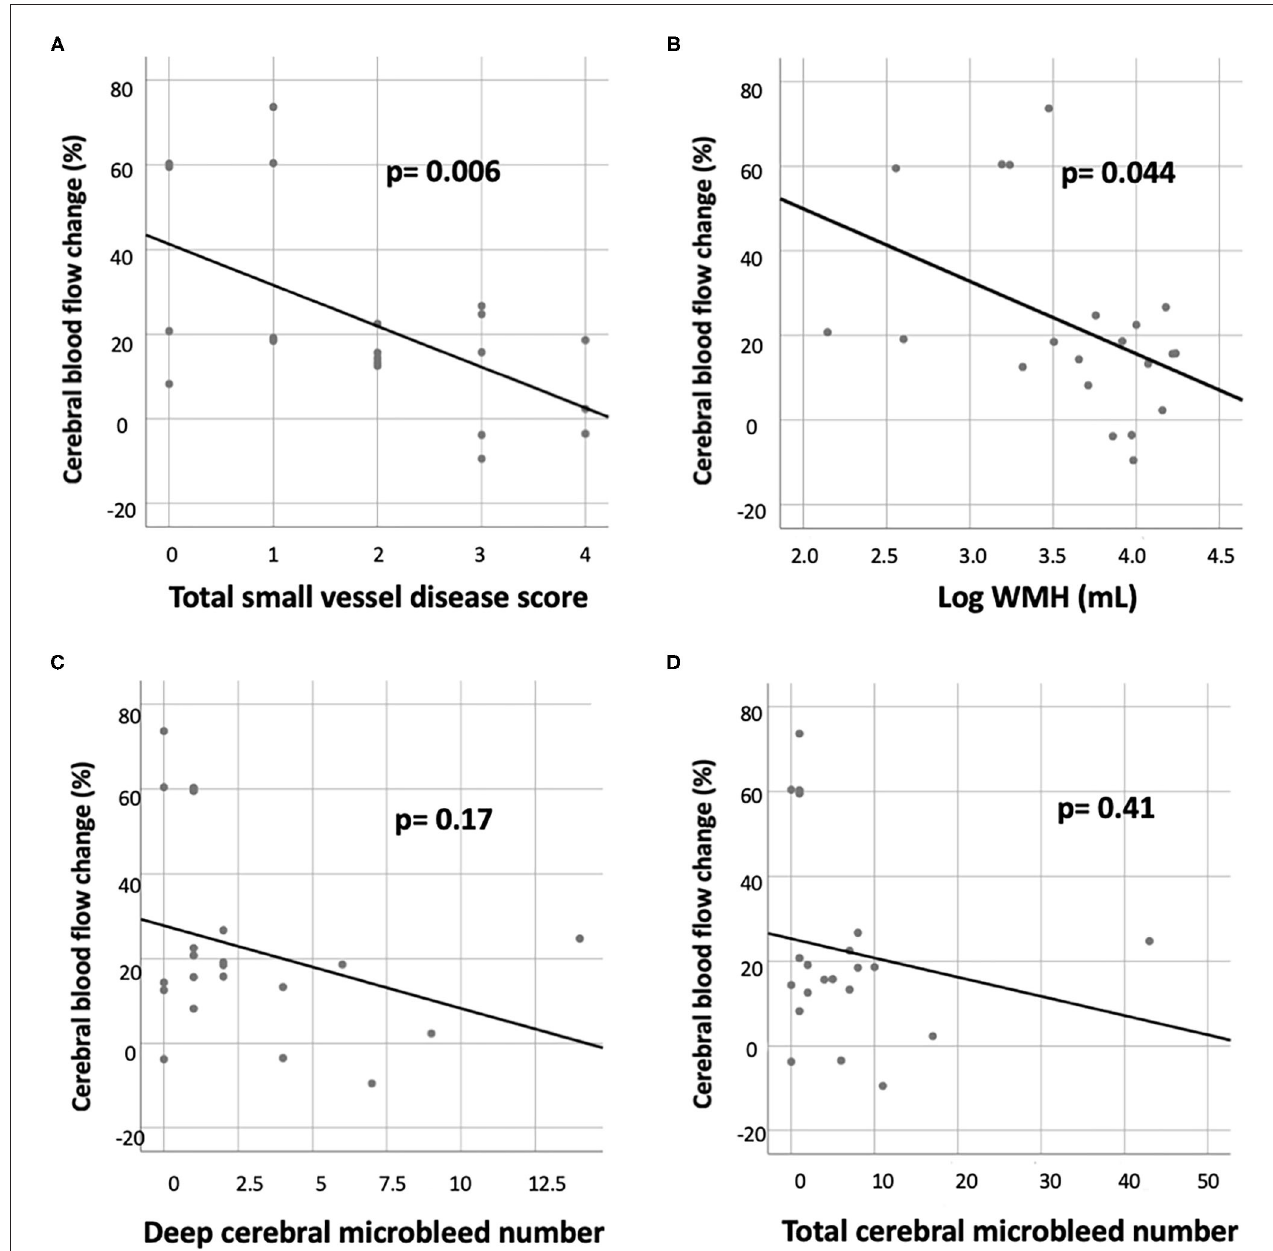
FIGURE 2 | Correlation of CBF reduction in the basal ganglion with various small vessel disease markers in the ICH group, including (A) total small vessel disease score, (B) white matter hyperintensity (WMH) volume (log transformed), (C) deep cerebral microbleed number, and (D) total cerebral microbleed number.